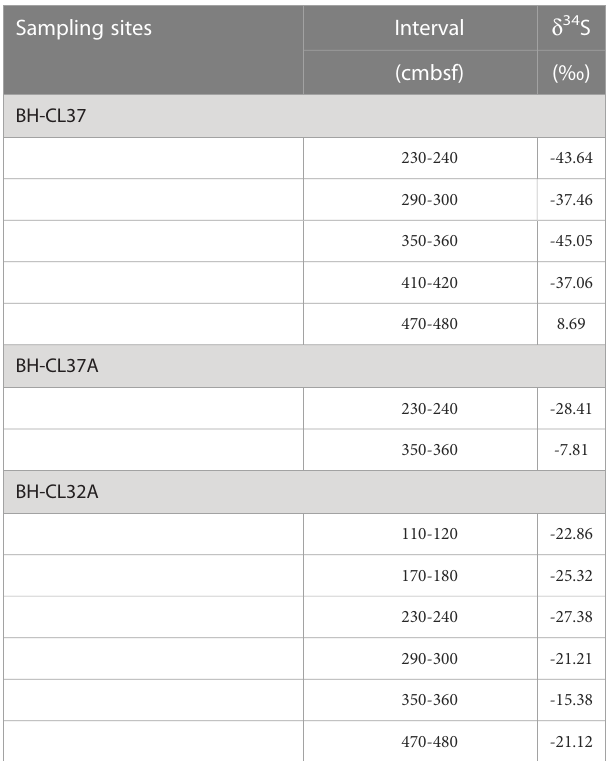
TABLE 7 Results of sulfur isotopes of tubular pyrites in sediments.